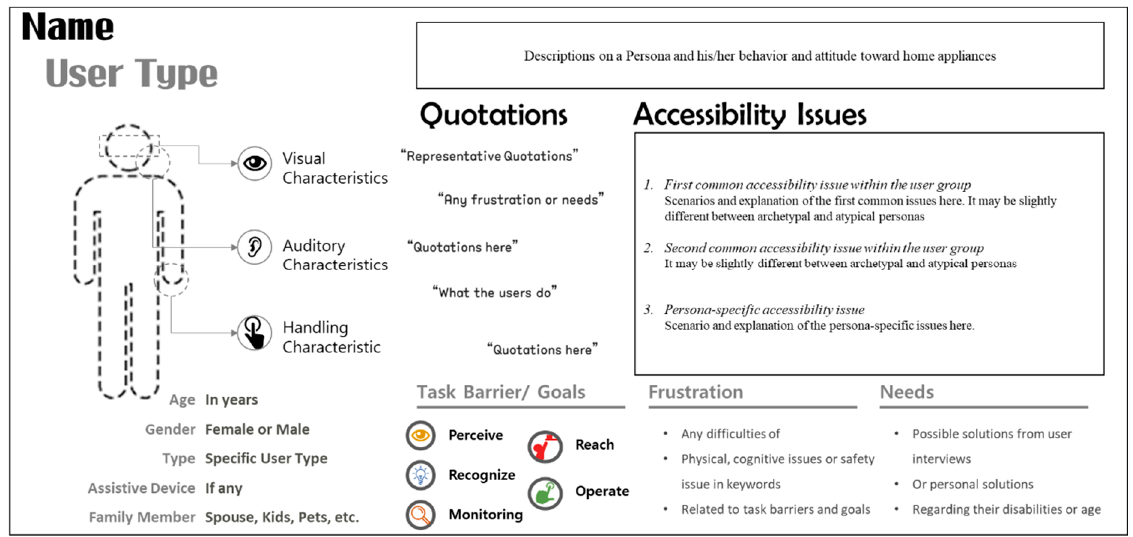
Figure 3. Persona card template.